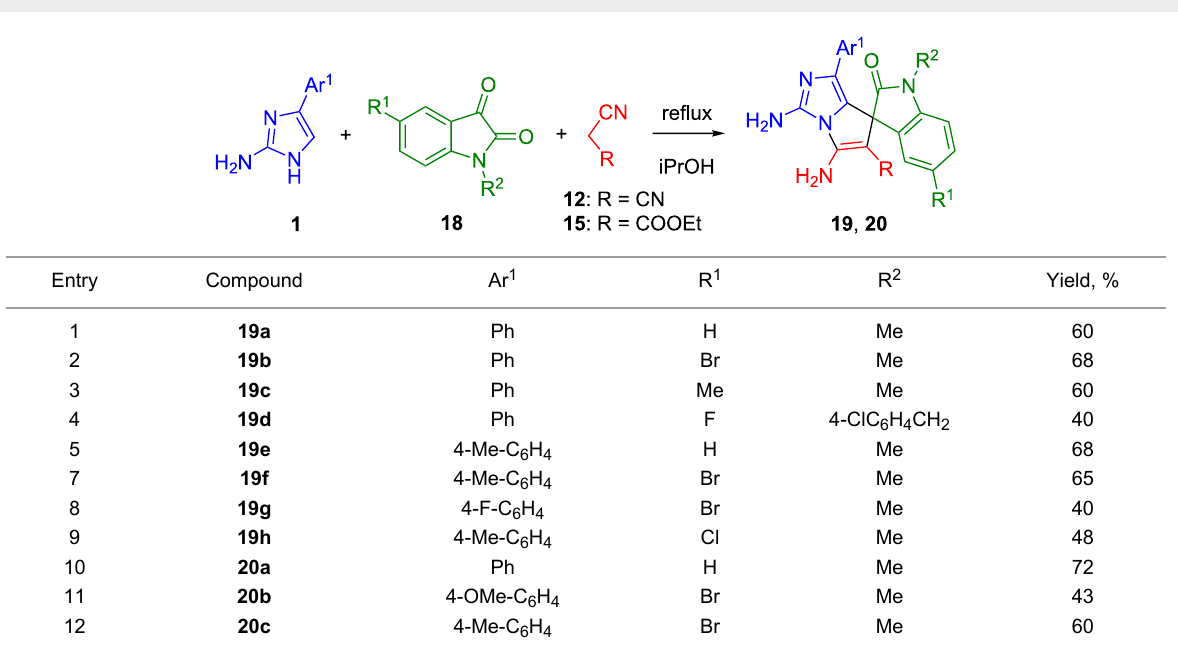
Table 4: Synthesis of spirooxindoles 19 and 20